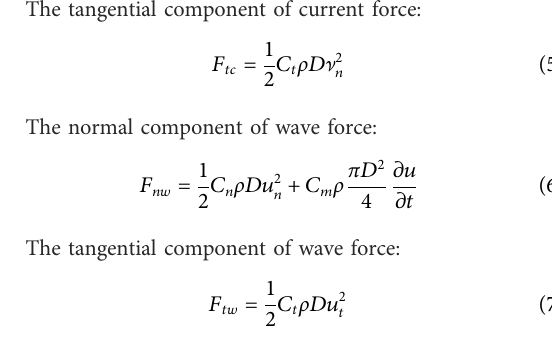
FIGURE 5 Veri fi cation of the modeling